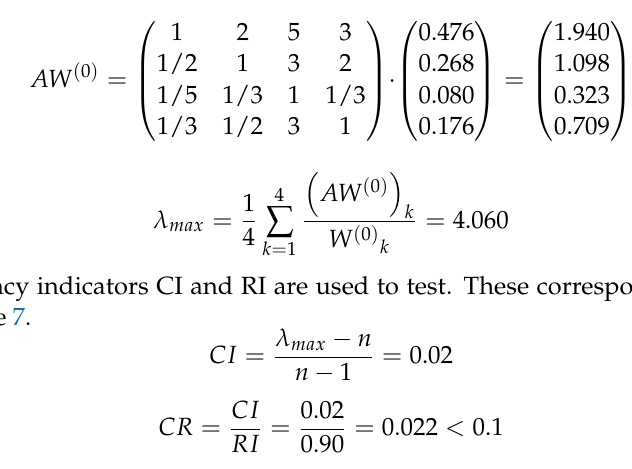
Table 7. Consistency test corresponding value table.